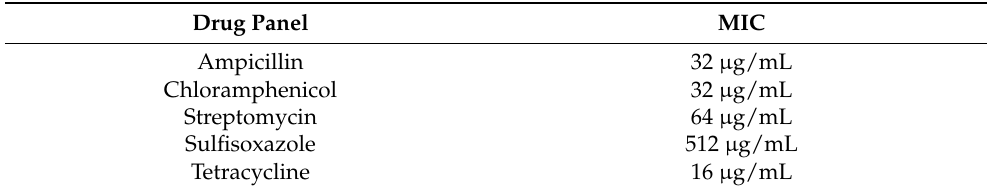
Table 1. Recommended MIC values for Salmonella enterica serotype Typhimurium for the ACSSuT pattern according to 2014 CLSI standards. Drug Panel MIC